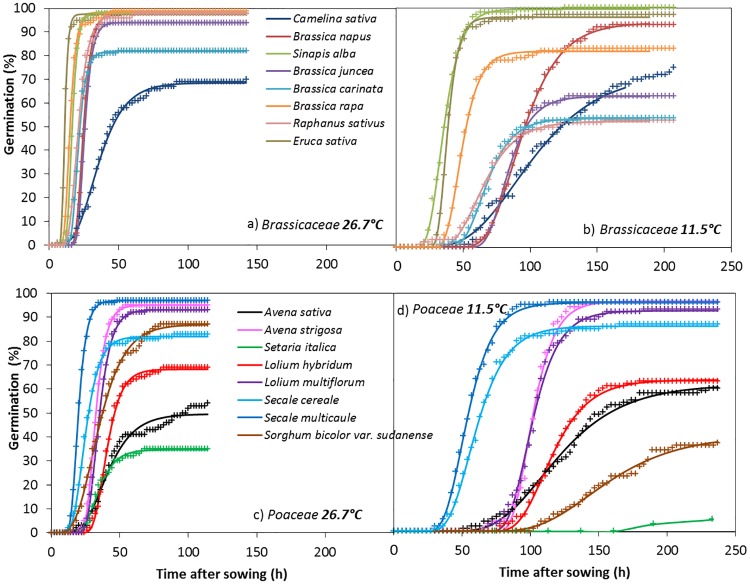
Variation in germination dynamics for Brassicaceae cover crops at a) 26.7°C and b) 11.5°C and for Poaceae cover crops at c) 26.7°C and d) 11.5°C.Crosses represent observed data and lines represent fitted Gompertz functions.